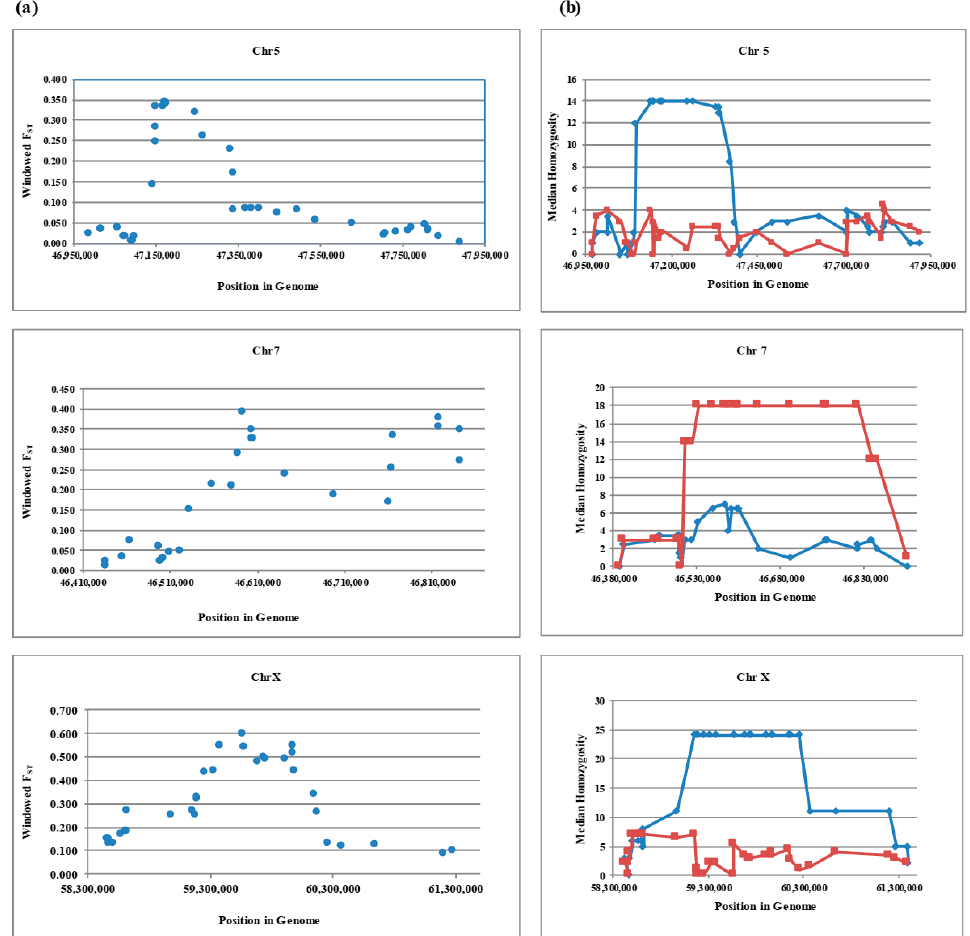
Figure 1. Plots of windowed F ST ( a ) and run of median homozygosity ( b ) in relation to genomic position for thin and fat tail breeds in candidate regions: SNP positions in the genome (bp) are shown on the X-axis, and windowed F ST or median homozygosity are plotted on the Y-axis. Fat and thin tailed breeds are shown by blue diamonds and red squares respectively on median homozygosity plot.